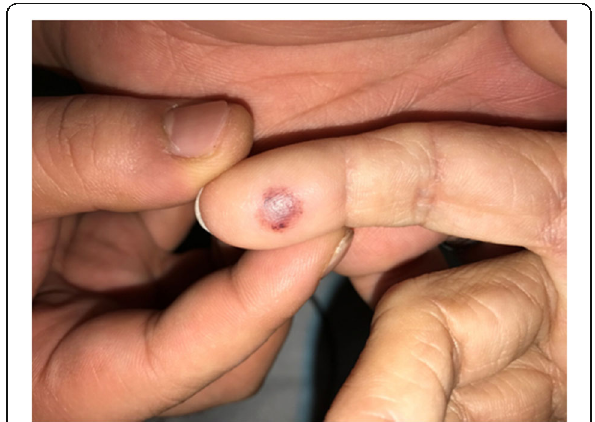
Fig. 1 Blister on the left ring finger where the pulse oximeter had been placed during general